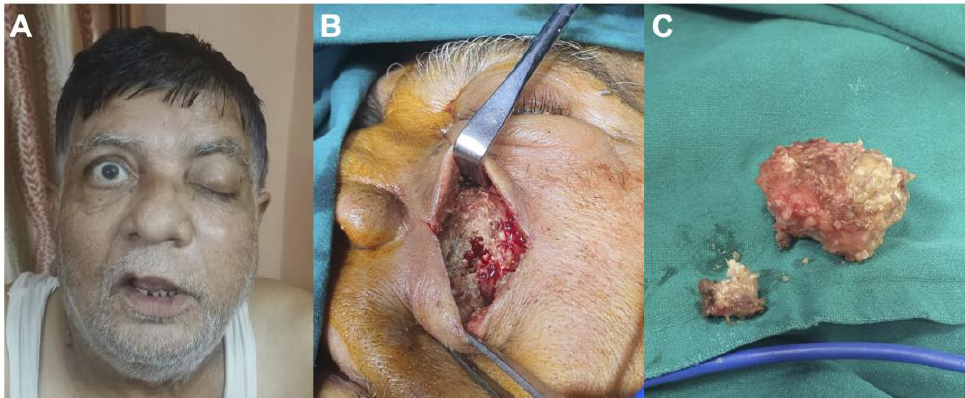
Figure 1. Case of a 65-year-old man suffering from mucormycosis following therapies for COVID-19 pneumoniae: ( A ) preoperative photography showing left ptosis and facial swelling; ( B ) preoperative photography demonstrating invasion of the sinus by mucormycosis; ( C ) preoperative photography showing surgical removal of the mucormycosis.